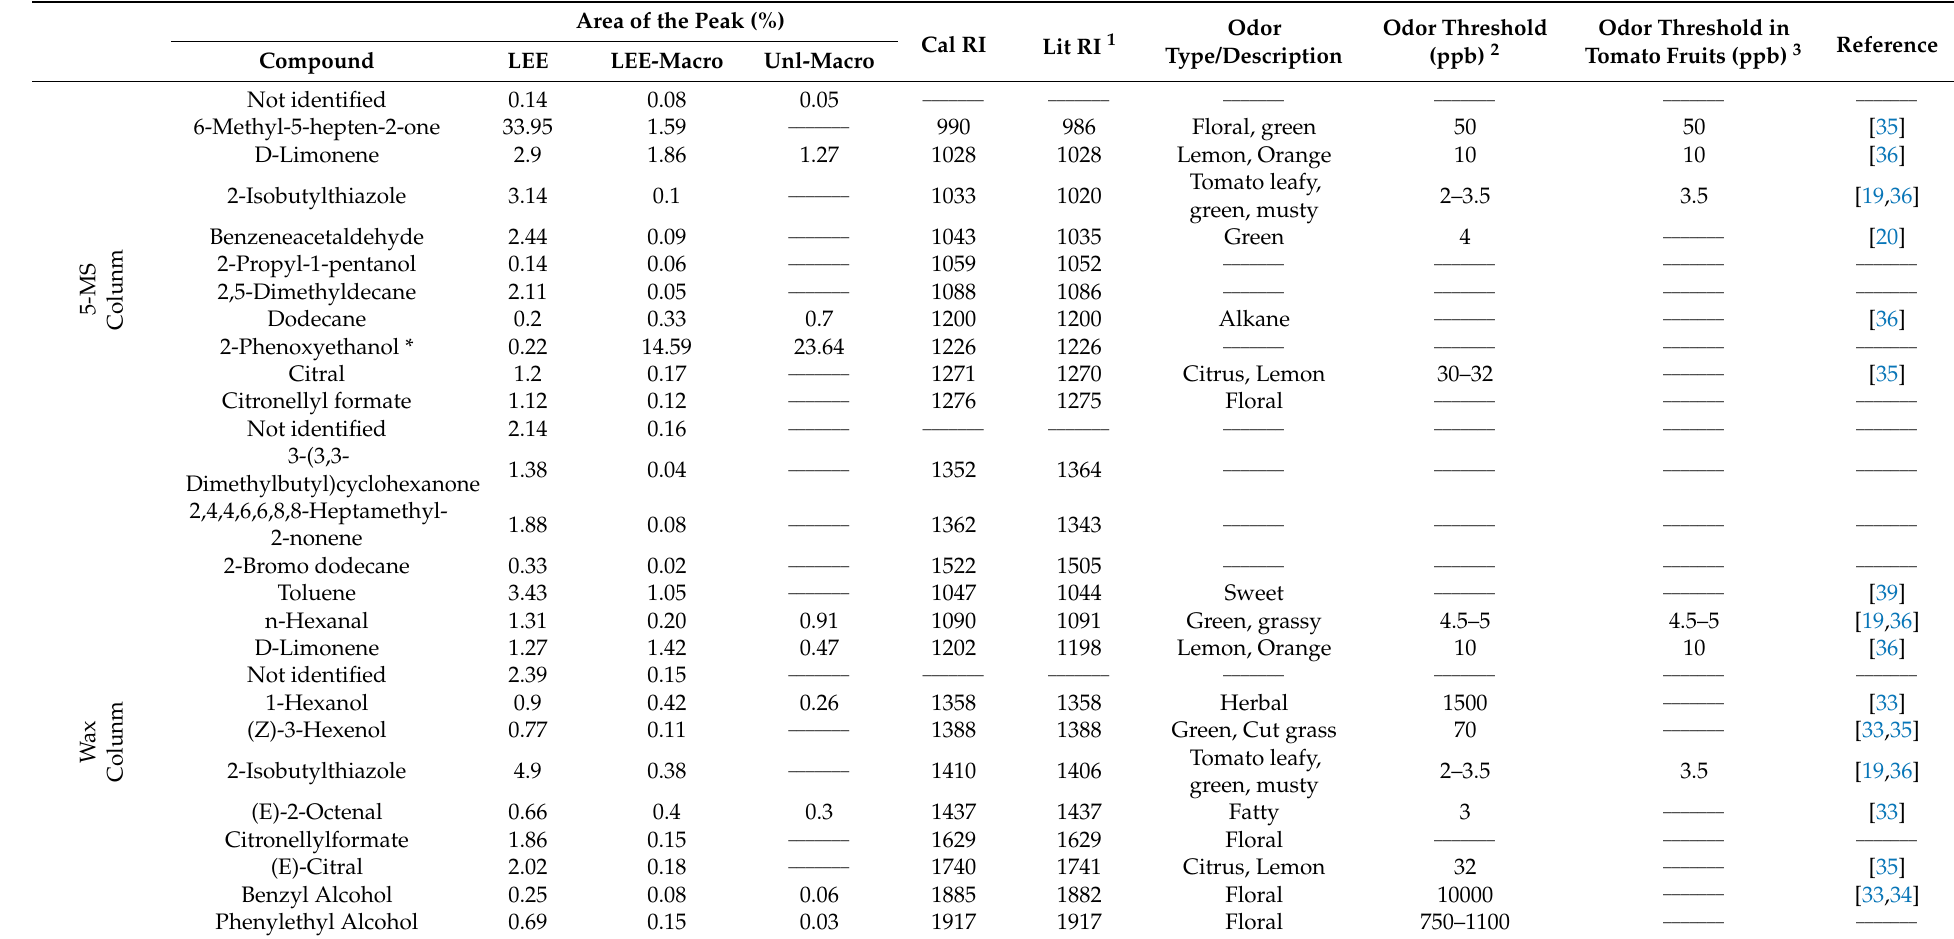
Table 2. Characterization parameters of volatile compounds in LEE, LEE-Macro and Unl-Macro identified through GC-MS